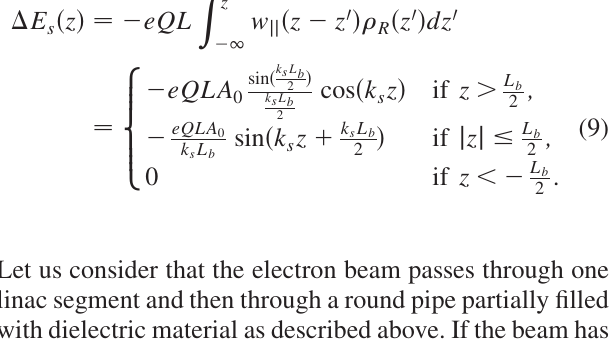
ffiffiffiffiffiffiffiffiffiffiffiffi p (cid:2) (cid:1) 1